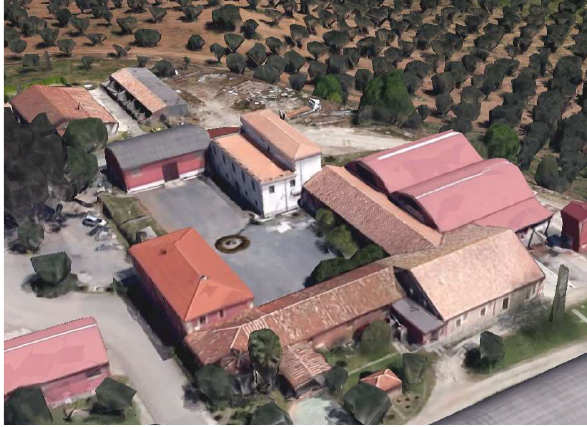
Figure 2. 3D vision of the case study: a historic rural building complex in Calabria.